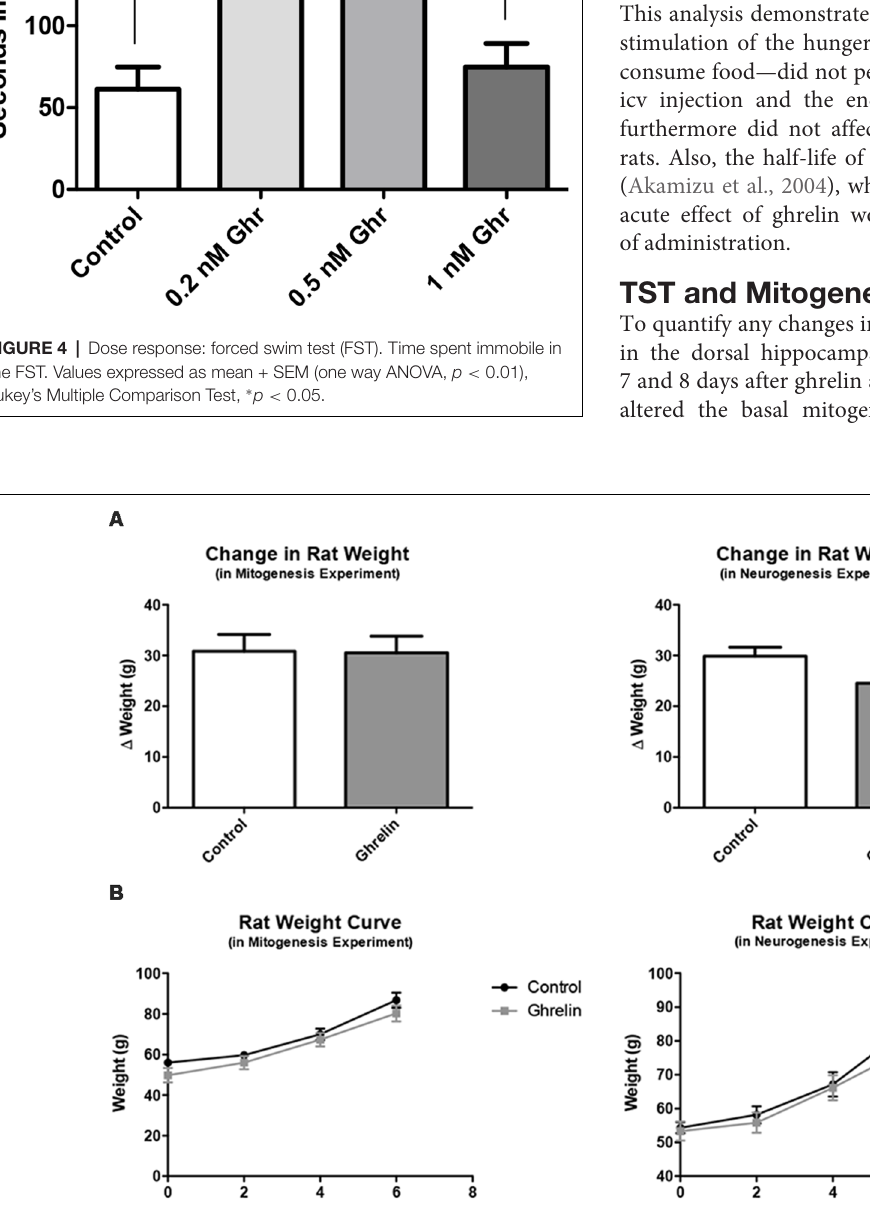
Frontiers in Behavioral Neuroscience |